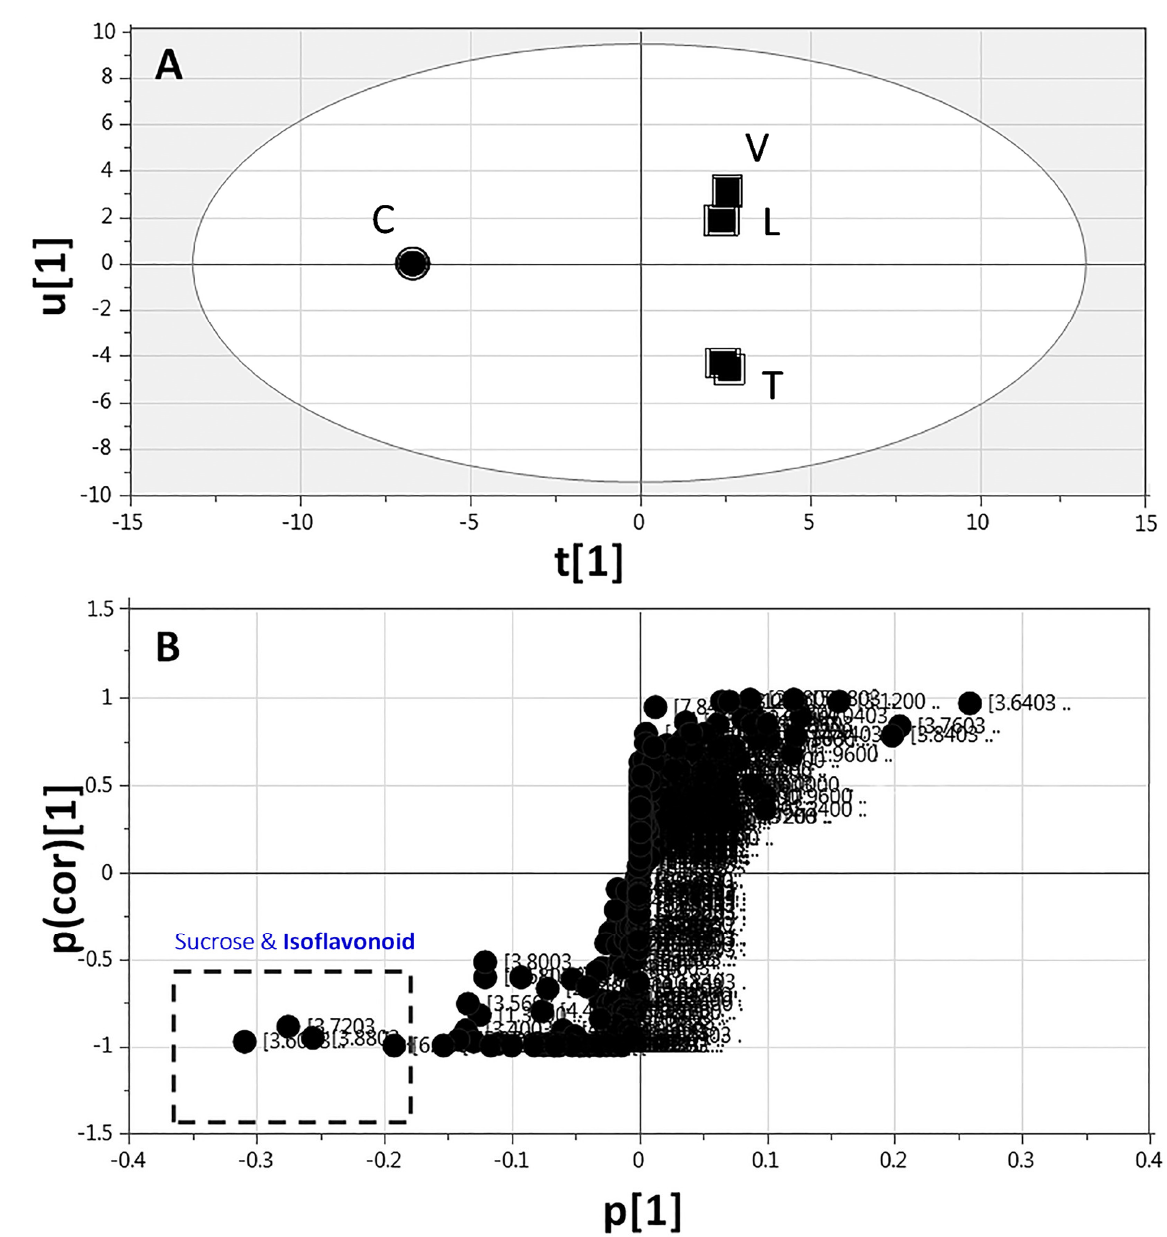
Figure 4. Full-range 1 H-NMR (δ 11.0–0.0 ppm)-based orthogonal projection to latent structures-discriminant analysis (OPLS-DA) of Cicer sprouts (●) modelled against the remaining legume sprouts ( ■ ) ( n = 3). ( A ) OPLS-DA score plot and ( B ) loading plot derived from samples modelled against each other. The loading S-plot shows the covariance p[1] against the correlation p(cor)[1] of the variables of the discriminating component of the OPLS-DA model. Peak numbering follows those listed in Table 1 for metabolite identification using 1D- and 2D-NMR.